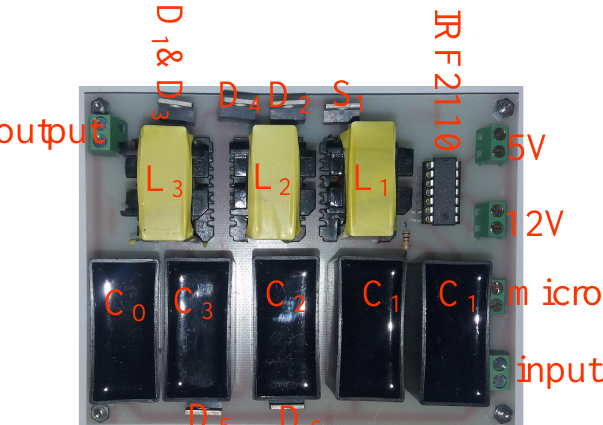
Figure 16. The prototype.